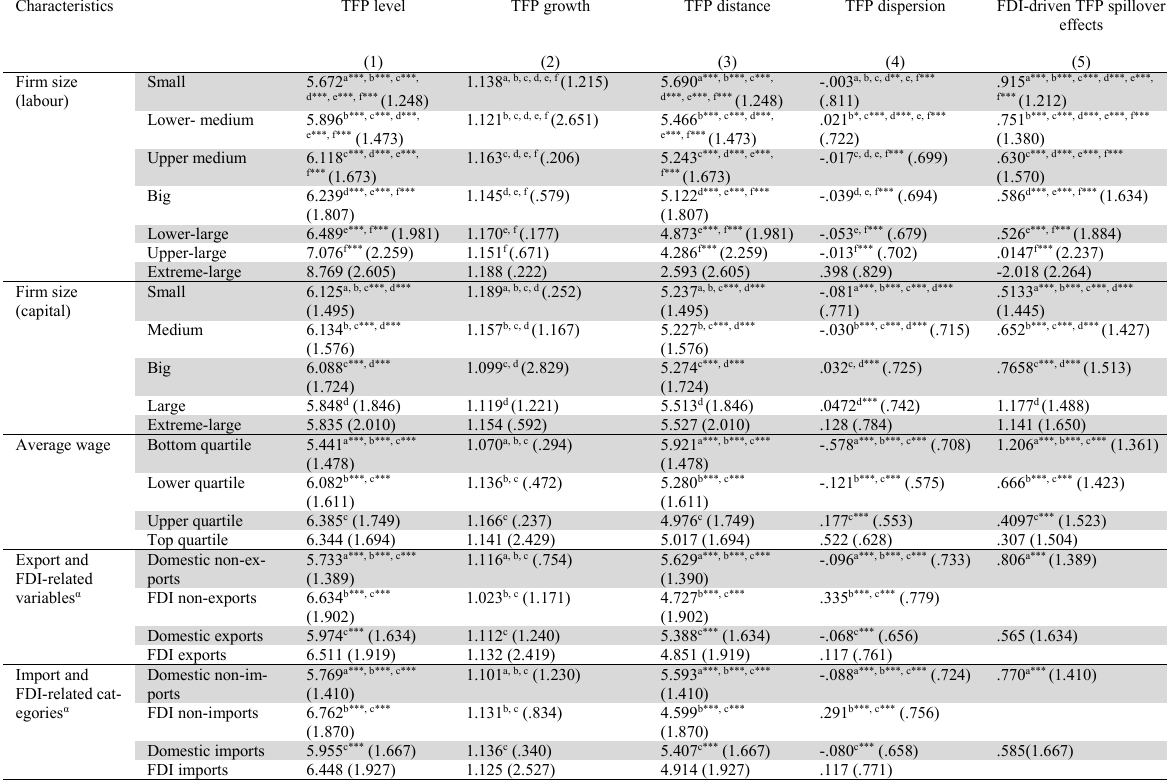
Firm heterogeneity in TFP level for Vietnamese manufacturing firms, 2010-2016